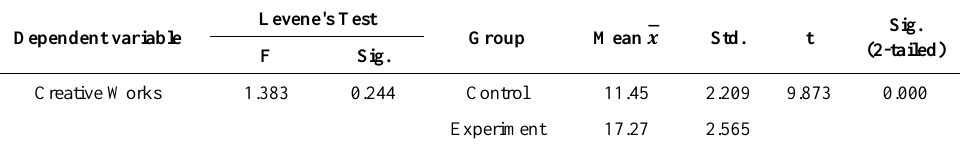
Table 5. Results of the T-Test analysis of creative works between the experimental and control